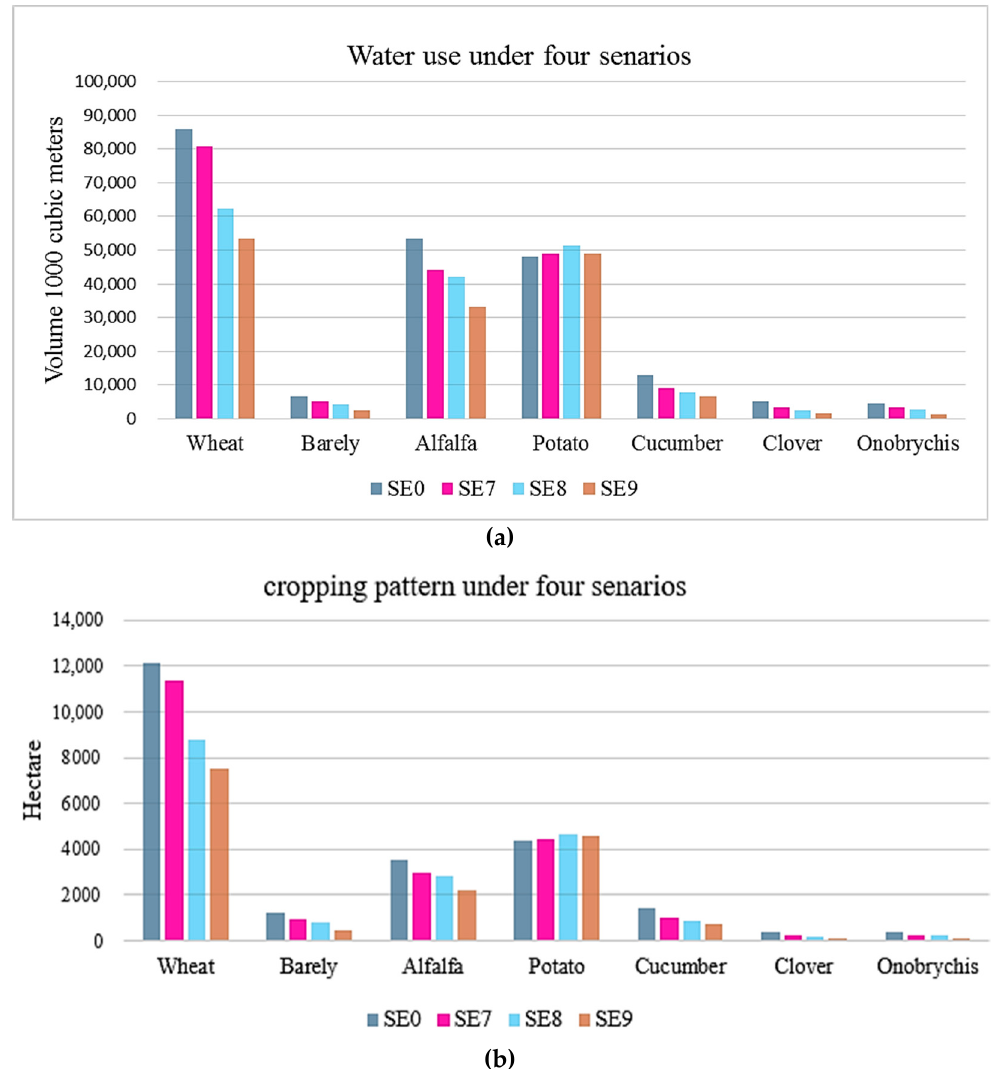
Figure 4. The results of solving positive mathematical programming model based on simultaneous scenarios of pricing and quota. ( a ) consumed water level. ( b ) cultivation pattern. ( see Table A3 for details)